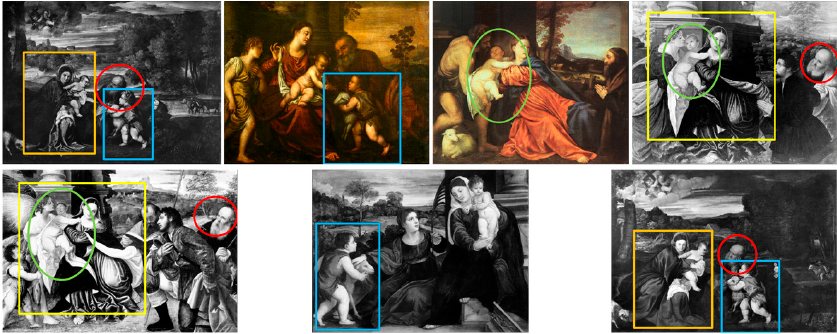
Figure 12. Exemple of Art historian annotation work on pattern propagation (author : Carlotta Stri- olo).